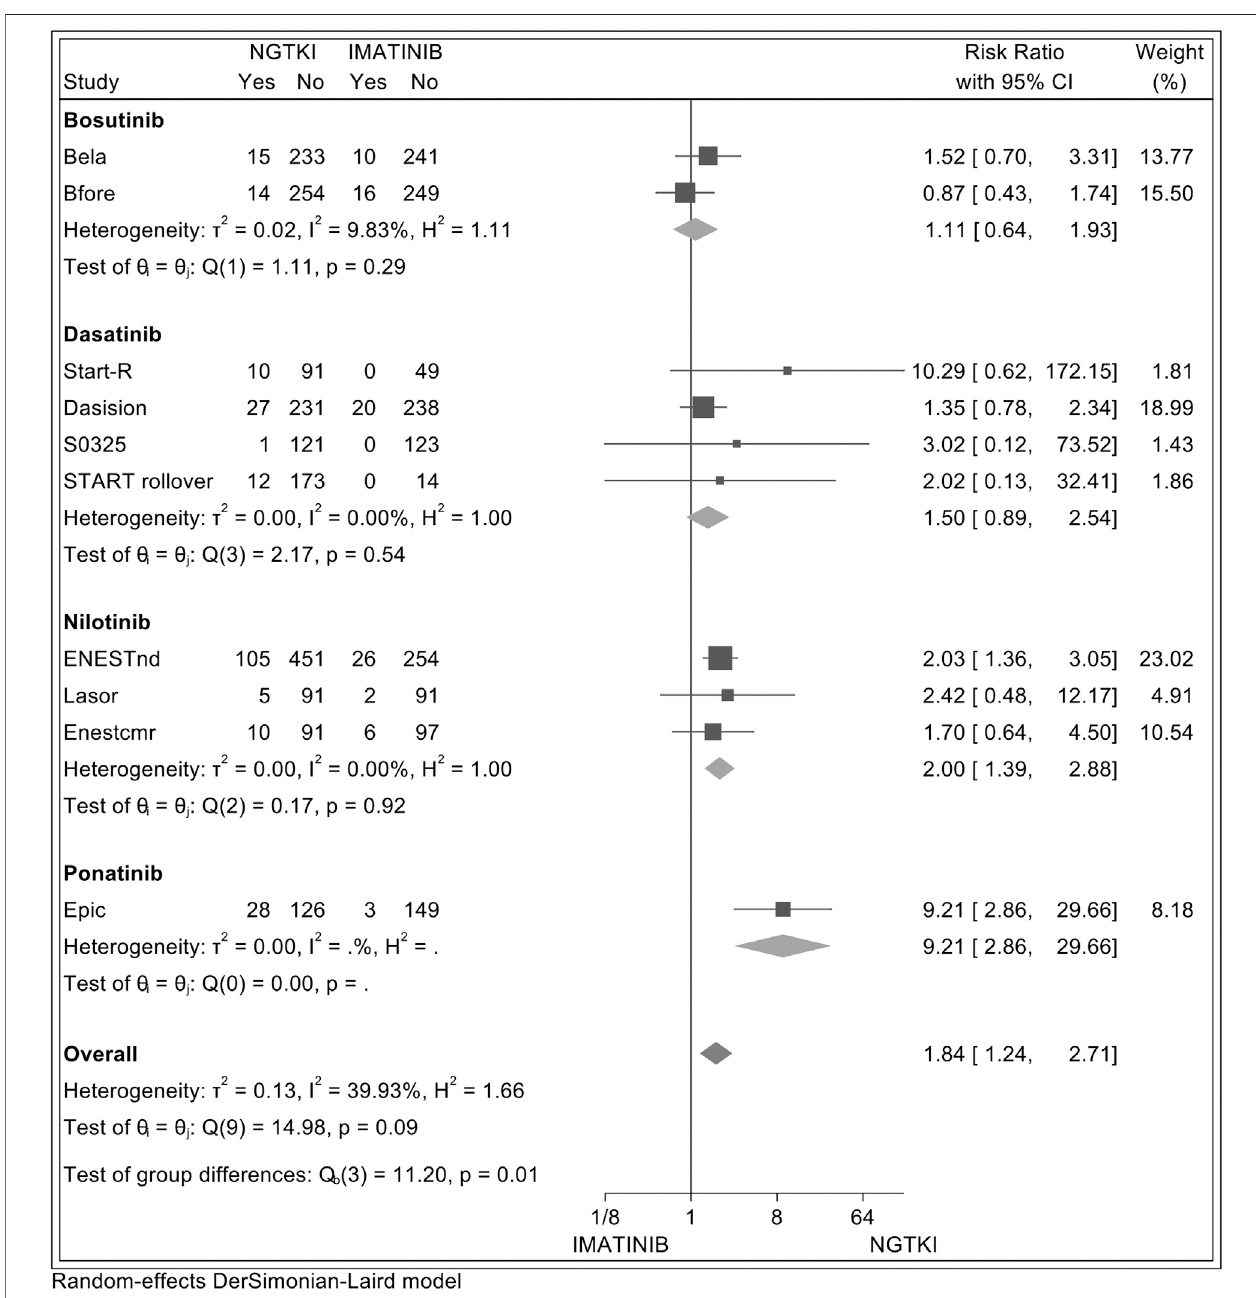
FIGURE 4 | Forest plot showing random-effect meta-analysis of hypertension between imatinib and subsequent-generation TKI.